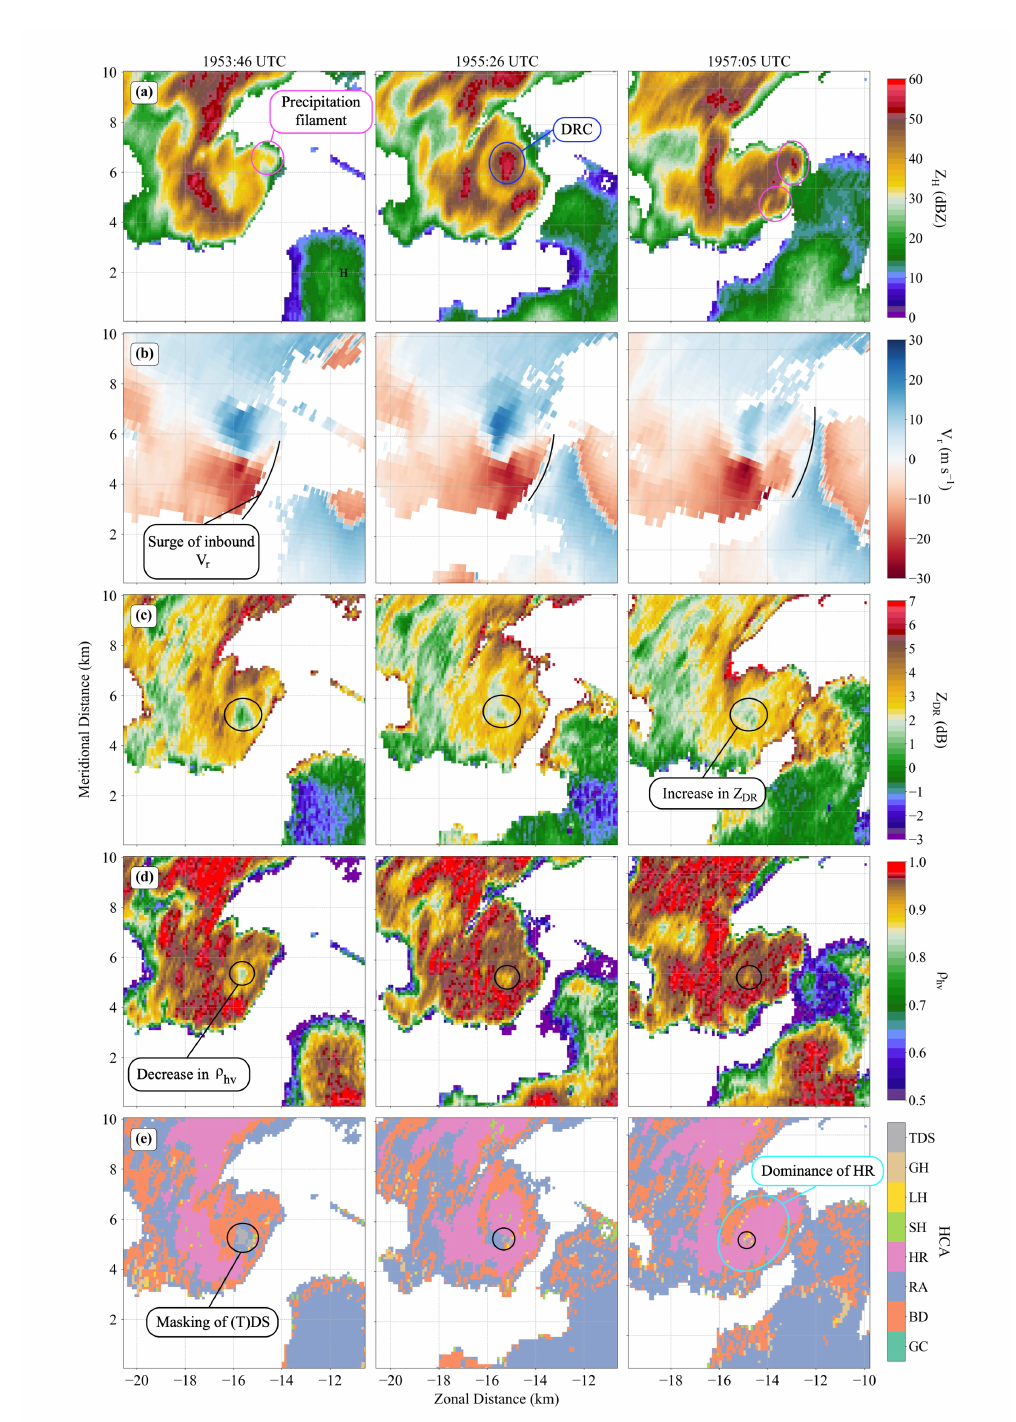
Figure 7. From top to bottom row ( a – e ): Z H , Doppler velocity ( V r ), differential reflectivity ( Z DR ), correlation coefficient ( ρ hv ), and HCA from PX-1000 for three subsequent times—from the left to right column, 1947:48, 1949:08, and 1952:27 UTC—highlighting surge A. Annotations detail polarimetric characteristics associated with the evolution of the momentum surge, except for surge B at 1953:46, 1955:26, and 1957:05